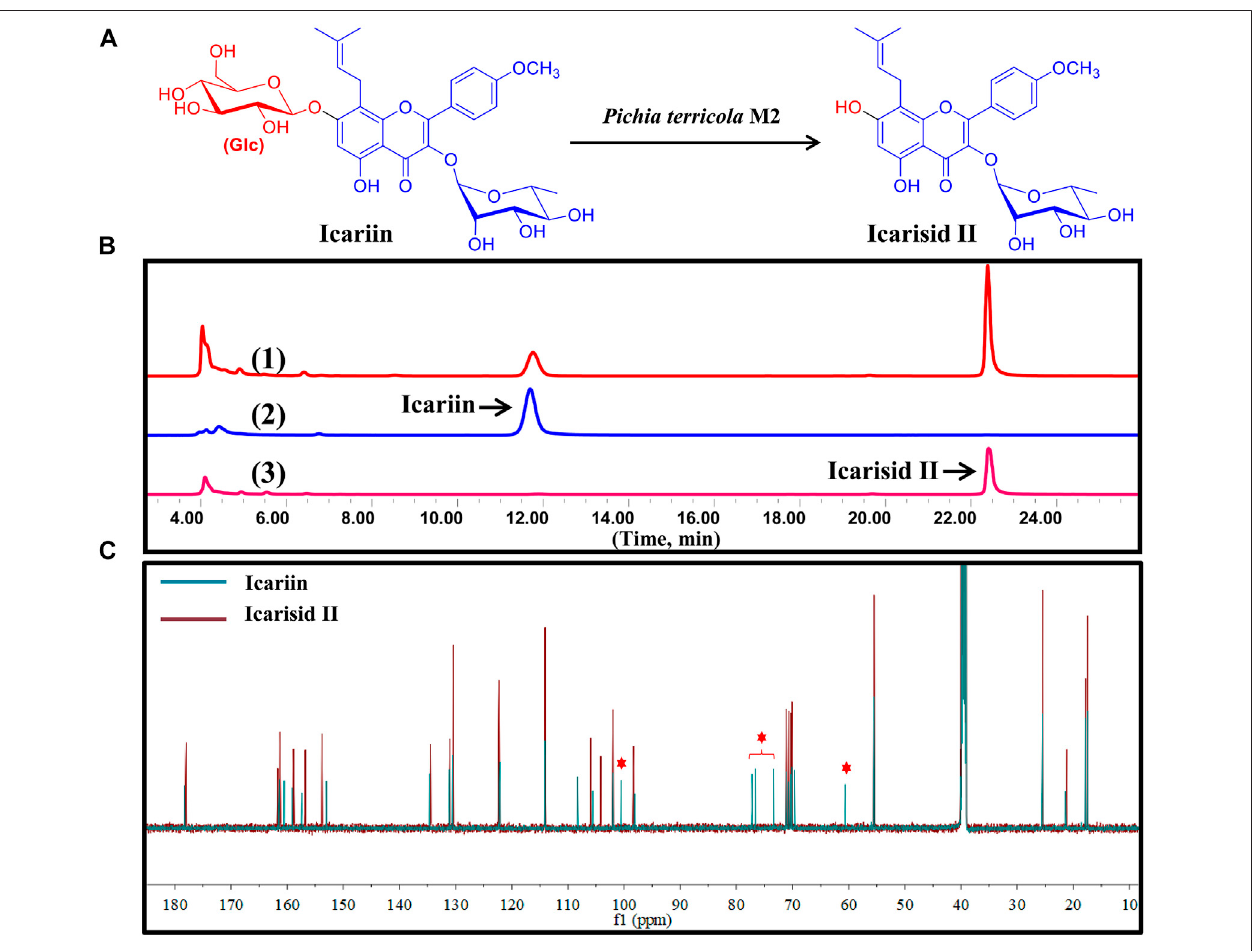
FIGURE 4| Icariin was transformed toIcarisid Ⅱ by intestinal fungus Pichia terricola M2. (A) Illustration for the biotransformation ofIcariinby Pichia terricola M2. (B) HPLC chromatograms for the analysis of biotransformation of Icariin by Pichia terricola M2. (1) Co-incubation of Icariin and Pichia terricola M2. (2) Icariin reference. (3) Icarisid Ⅱ reference. (C) Comparison of the 13 C NMR spectra of Icariin and Icarisid Ⅱ .